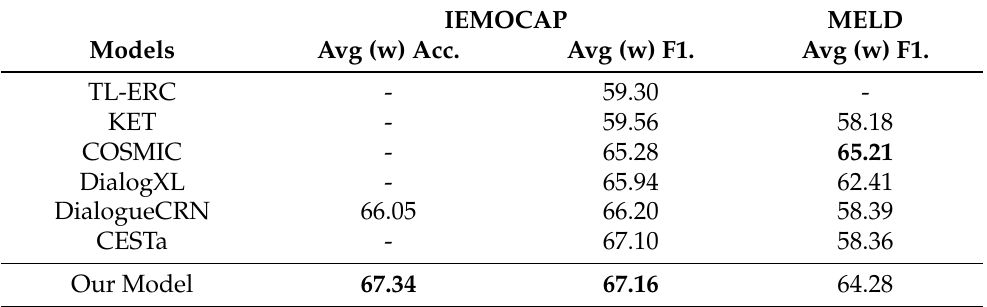
Table 5. Comparisons with baselines and our method. Avg(w) refers to weighted average, Acc refers to the accuracy and F1 refers to the f1-score. Best performances are highlighted in